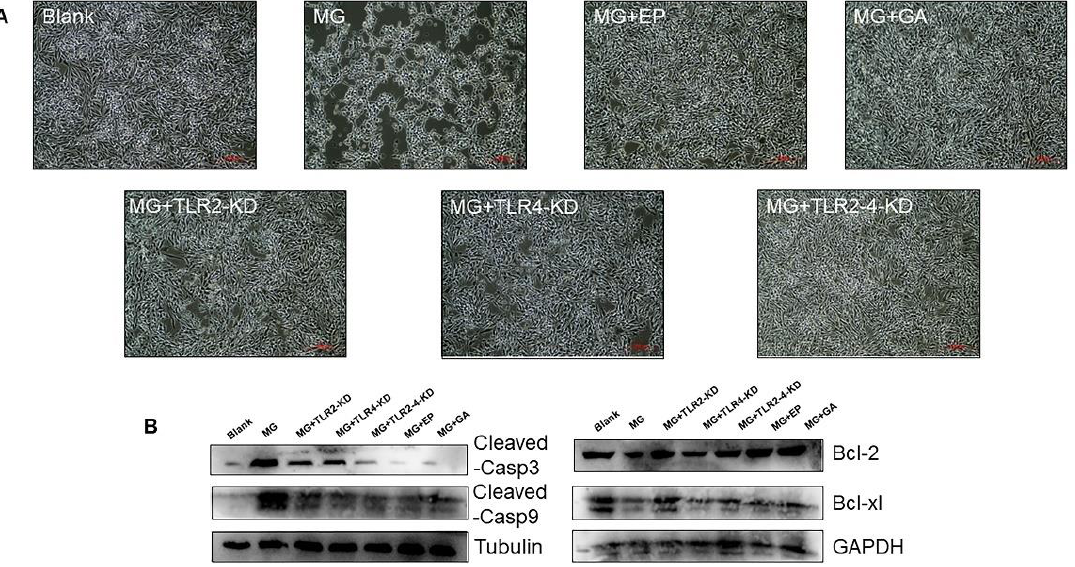
Figure 5. Inhibition of HMGB1 alleviates MG-induced apoptosis. ( A ) HD-11 cells apoptosis ob- served by microscopy (scale bar, 200 µm). ( B ) The proteins of apoptosis genes were detected by Western blotting. Tubulin and GAPDH were used for